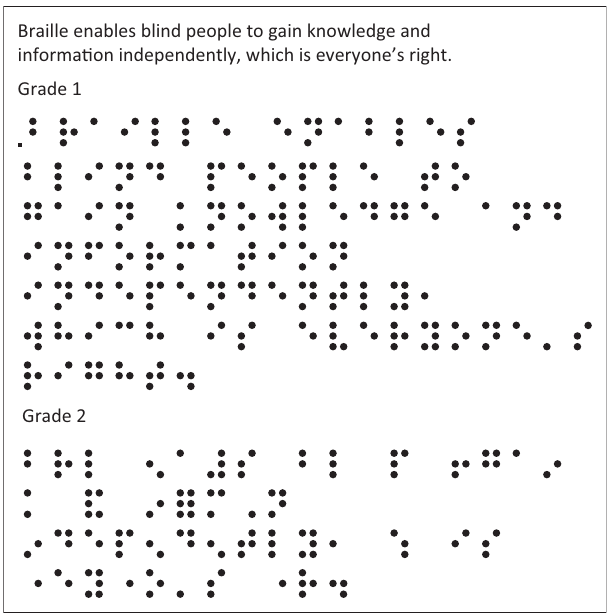
FIGURE 3: Braille letters of the alphabet.